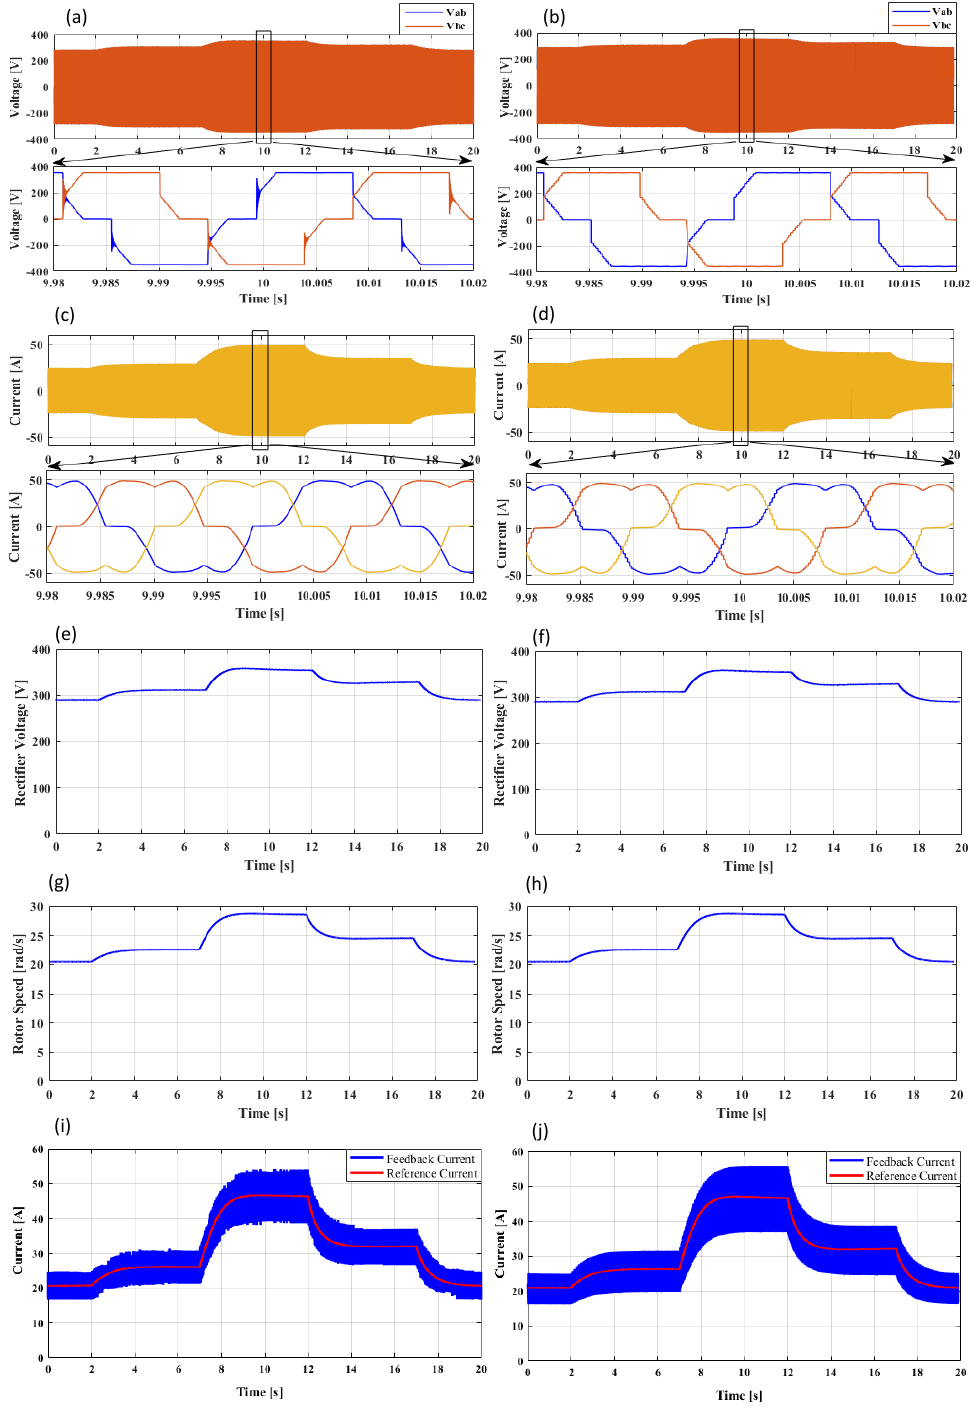
Figure 9. Healthy condition DoS results in time domain. ( a ) Three–phase line voltages of PMSG. ( c ) Three–phase stator currents of PMSG. ( e ) Output voltage of the three–phase diode rectifier. ( g ) Rotor speed of PMSG. ( i ) Feedback and reference currents at the input of boost converter. Healthy condition DRTS results in time domain. ( b ) Three–phase line voltages of PMSG. ( d ) Three–phase stator currents of PMSG. ( f ) Output voltage of the three–phase diode rectifier. ( h ) Rotor speed of PMSG. ( j ) Feedback and reference currents at the input of boost